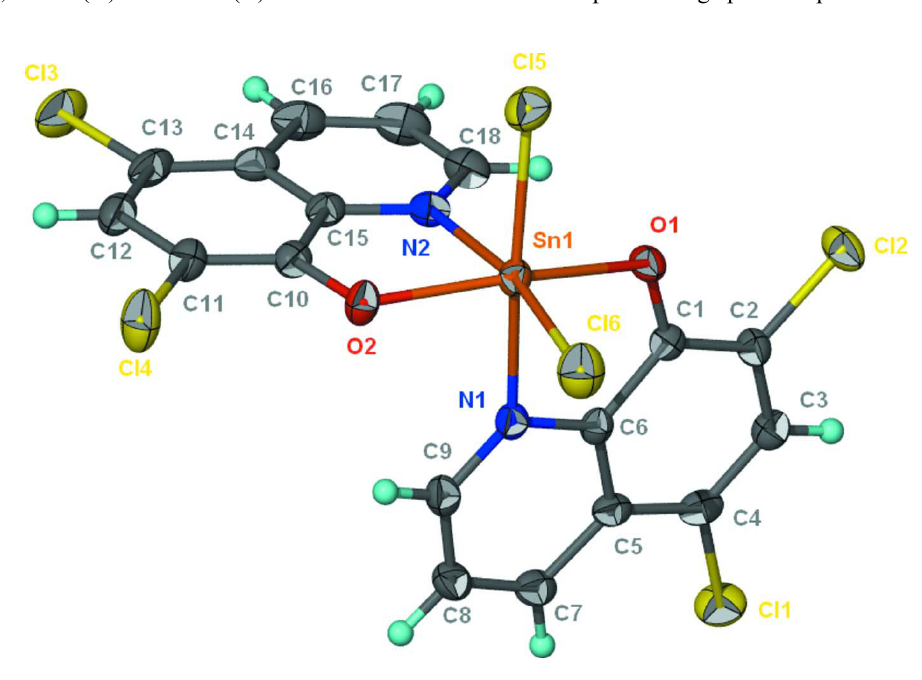
Anisotropic displacement ellipsoid plot (Barbour, 2001) of SnCl probability level and H atoms of arbitrary